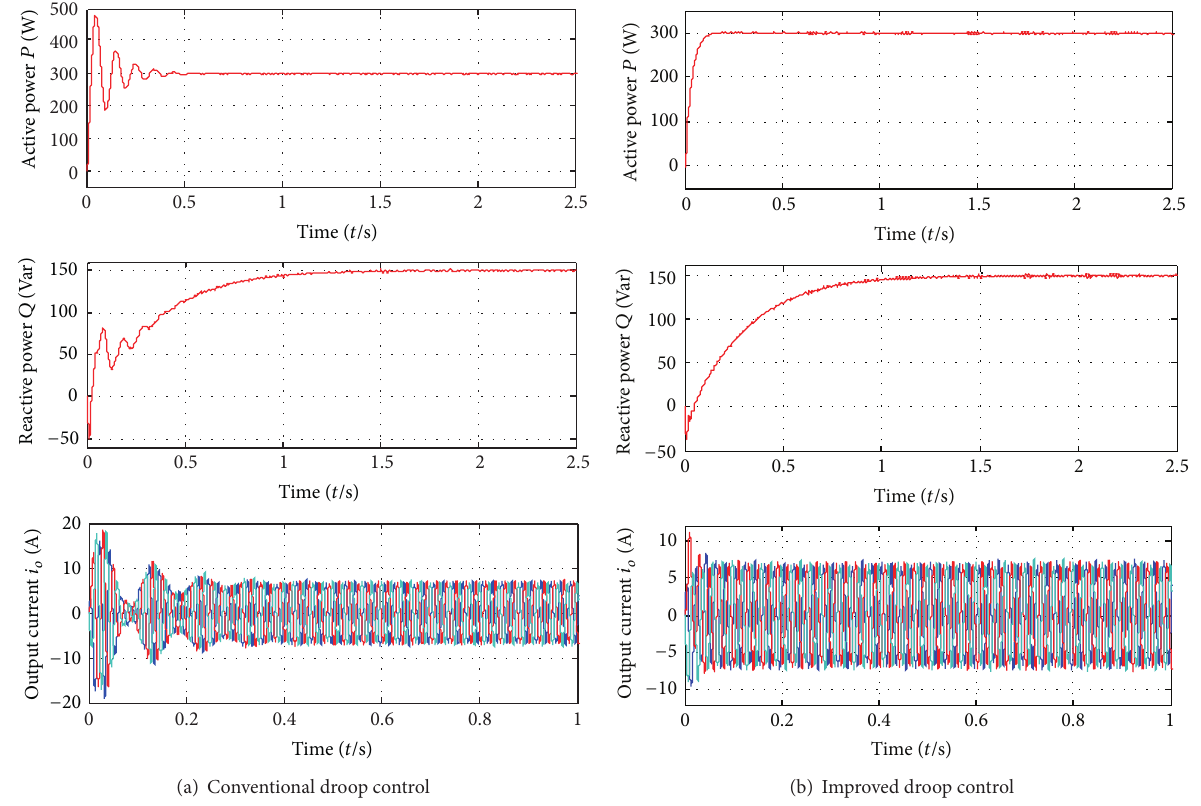
Figure 7: Simulation results of transient